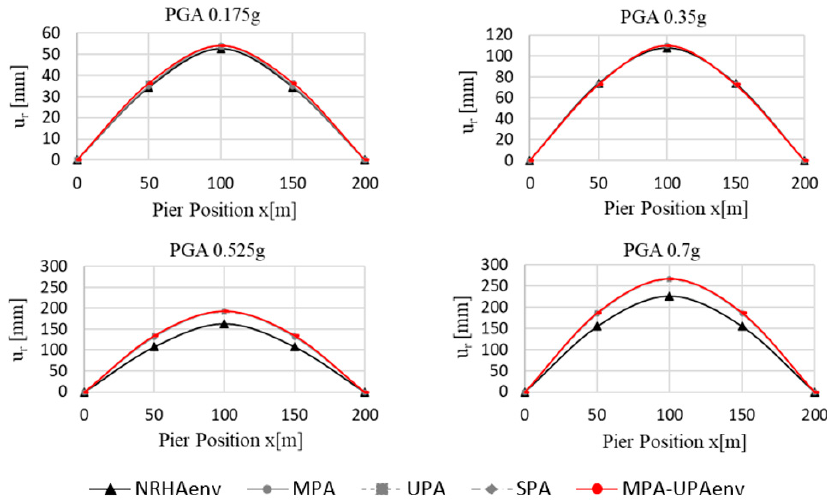
( c ) Figure 13. Irregular bridge—deck displacements derived by performing pushover analysis (ag = 0.7 g), with a load pattern proportional to the main mode shapes, with respect to different monitoring points (M.P.). Pushover with Mode 1 ( a ), Mode 3 ( b ) or Mode 4 ( c ). According to what we discussed in Section 2, the same results can be finally obtained by selecting one or the other MP (it should be considered that a wrong selection can return a complex analysis calibration). According to some modal shapes, a null or quasi-null modal coefficient (or with an opposite sign if compared with the main bridge incremental deformation) can compromise the analysis (e.g., Pier 2 @ Mode 1 of the RB—Figure 11 and IB—Figure 12 and Pier 2 @ Mode 4 for both the IB). Therefore, the selection of the top of Pier 1 as the most suitable monitoring point was adopted for both cases. 4.1. Analysis of the Regular Bridge (RB) The RB was analyzed at several seismic intensity levels: from PGA = 0.175 g to PGA = 0.7 g, with PGA = 0.35 g being the design value. Since the response of this bridge was governed by one dominant mode (Mode 2), with Mode 2 and Mode 4 being the modes considered in the multimodal approach, and since the mode shape was